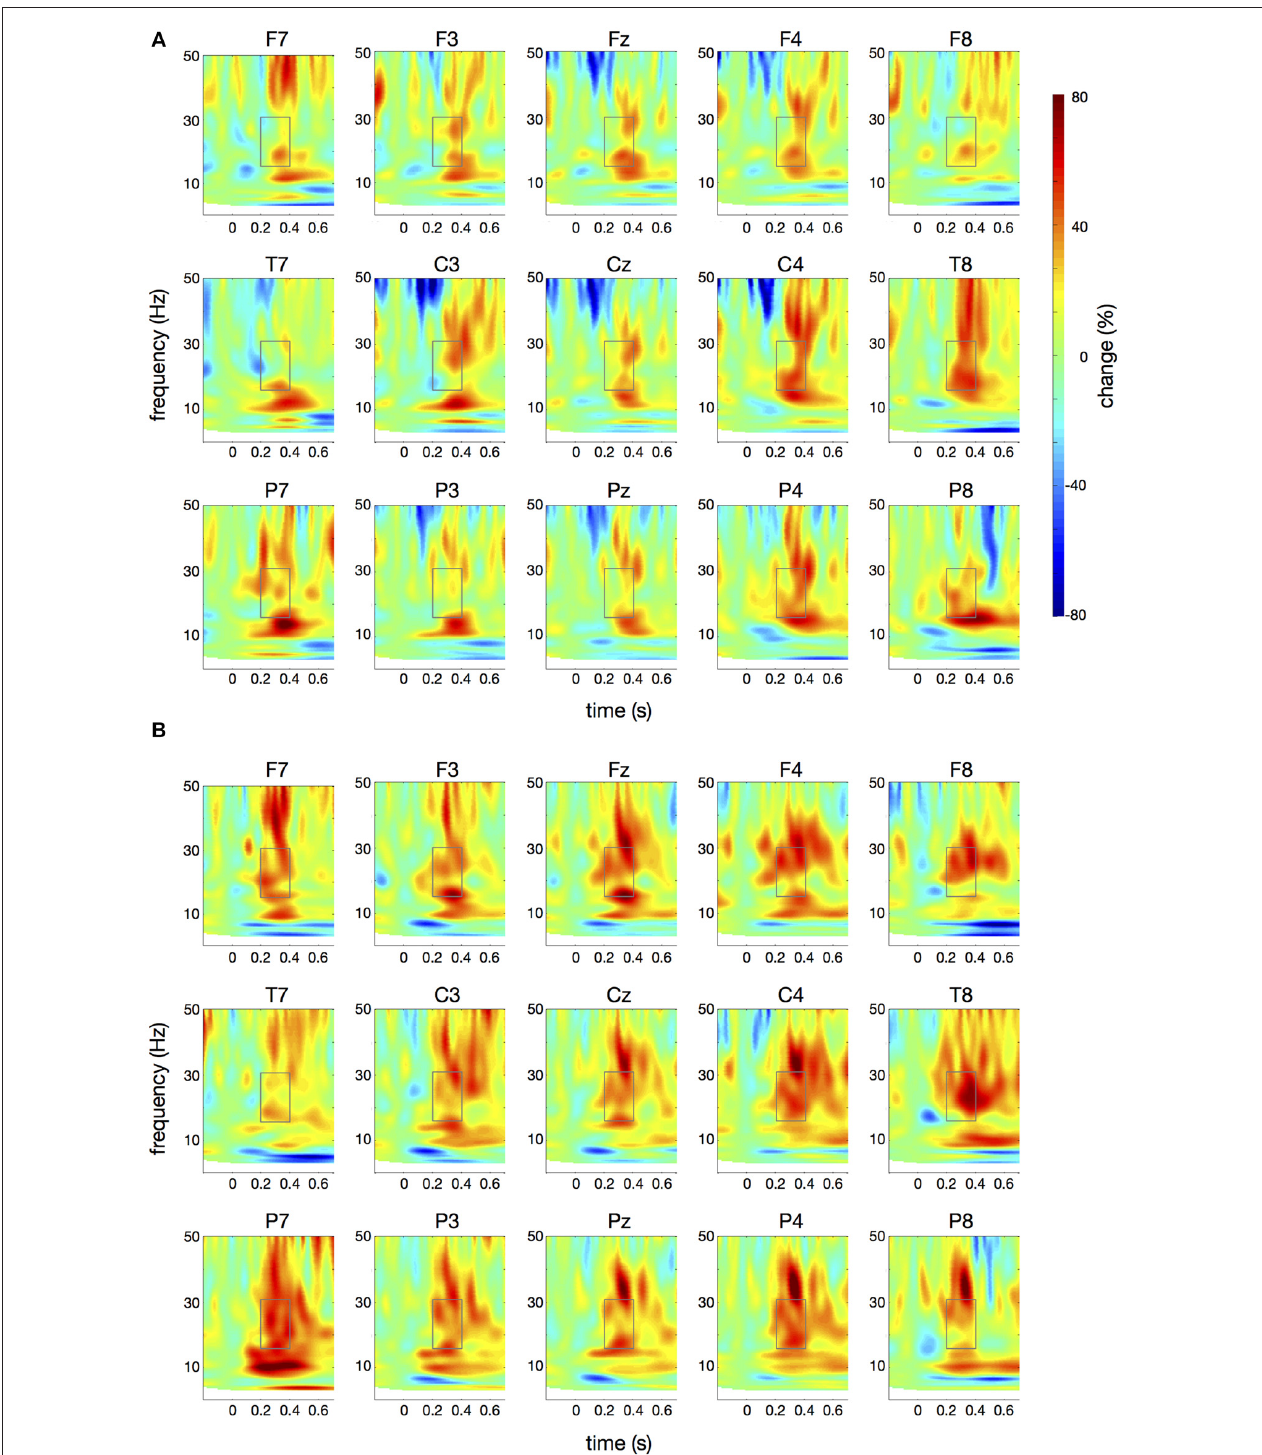
FIGURE 6 | Differences in time-frequency spectra between controls and patients. For this figure, averaged changes in spectral power in controls, relative to a baseline period of − 100 ms to 0 ms, were subtracted from changes in spectral power in patients. Yellow and red colors indicate higher spectral power in patients vs. controls. Time (in seconds) is shown on the x -axis; 0 s is the onset of the visual cue. Frequency (1–50 Hz) is shown on the y -axis. (A) displays the difference in spectral power for the papapa condition, (B) for the pataka condition. The boxes represent the frequency range (16–31 Hz) and time window (200–400 ms) of the